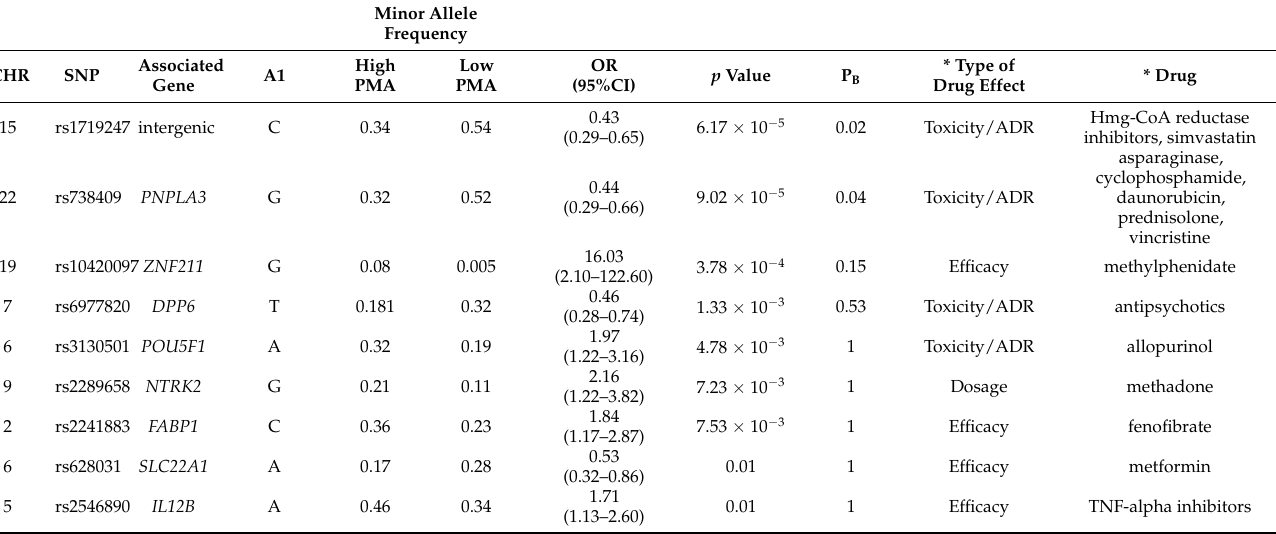
Table 2. Association analysis of single nucleotide polymorphism markers in participants with high and low proportion of Mapuche